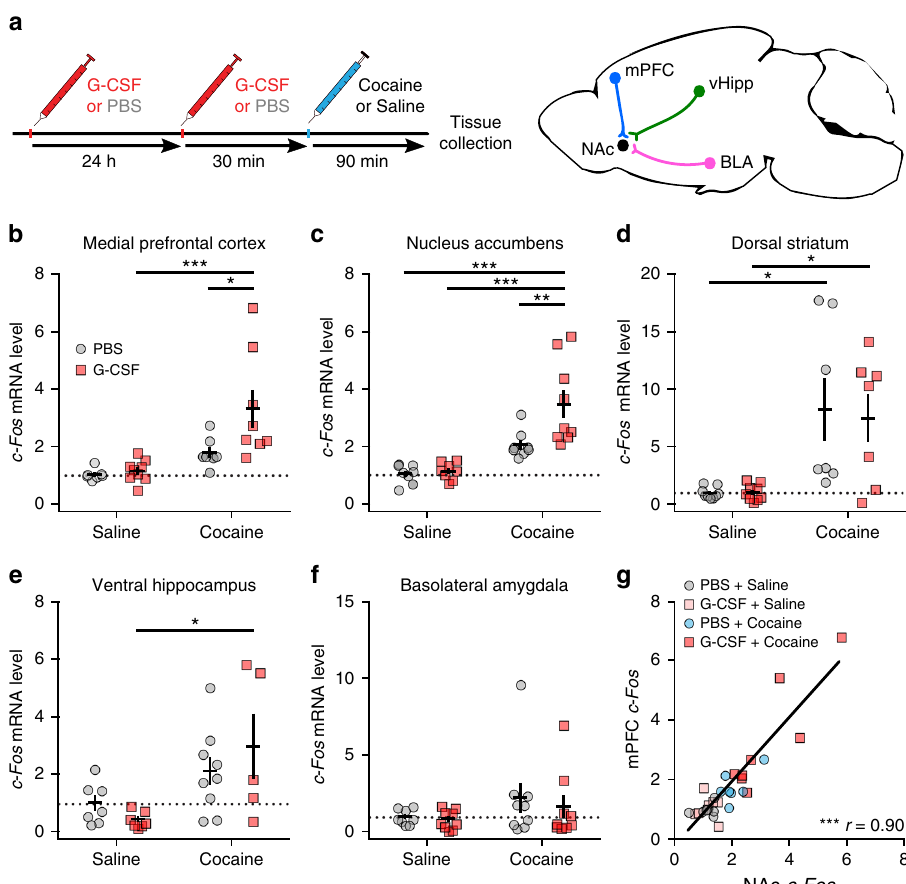
Fig. 2 G-CSF potentiates cocaine-induced neuronal activation in speci fi c brain regions. a Experimental Timeline (left). Mice were i.p. injected with G-CSF (50 µ g kg − 1 ) or PBS 24 h and again 30 min before an injection of cocaine (20 mg kg − 1 i.p.) or saline and brain tissue was collected 90 min later. c-Fos expression was measured in critical brain regions involved in the motivation to self-administer cocaine (right): G-CSF enhanced cocaine-induced neuronal activation in the mPFC and NAc. b mPFC (two-way ANOVA – cocaine: F (1,27) = 16.41, p = 0.0004; G-CSF: F (1,27) = 5.243, p = 0.030; interaction: F (1,27) = 3.759, p = 0.063), c NAc (cocaine: F (1,29) = 33.62, p < 0.0001; G-CSF: F (1,29) = 6.803, p = 0.014; interaction: F (1,29) = 5.215, p = 0.030) d While cocaine increased neuronal activation in the dorsal striatum (two-way ANOVA – cocaine: F (1,28) = 20.76, p < 0.0001), there was no added effect of G-CSF (F (1,28) = 0.05115, p = 0.82) e Similar results were observed in the ventral hippocampus (F (1,24) = 11.46, p = 0.0024; G-CSF: F (1,24) = 0.07447, p = 0.79). f c-Fos was not signi fi cantly induced by cocaine in the basolateral amygdala (F (1,31) = 2.463, p = 0.13). g c - Fos expression levels were correlated between the NAc and mPFC (Pearson ’ s r = 0.904, p < 0.0001). Data represented as mean ± s.e.m. (* p < 0.05, ** p < 0.01, *** p < 0.001 for Holm-Sidak post-hoc